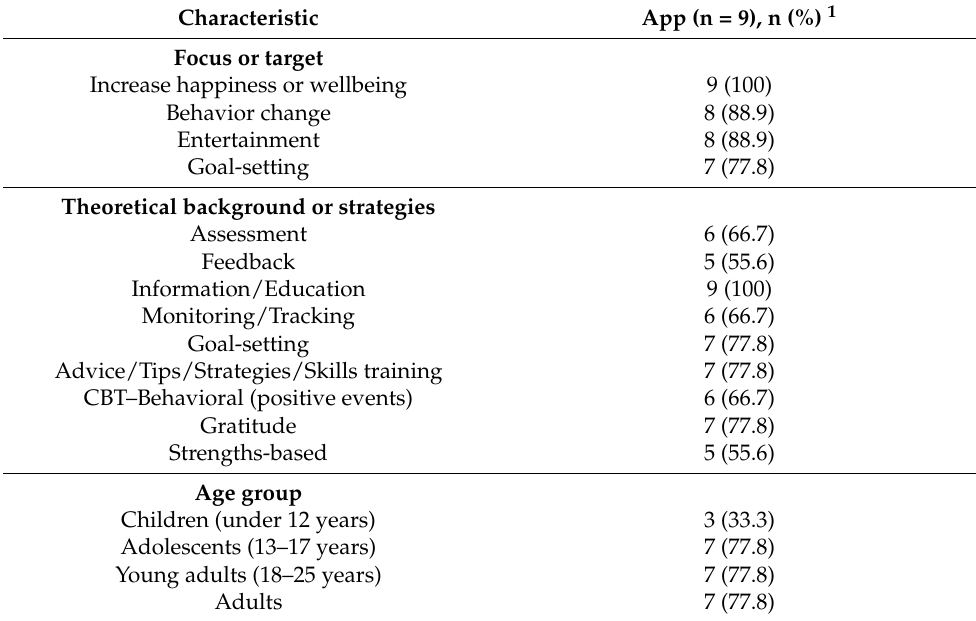
Figure 1. Flowchart of the oral-hygiene-related mobile apps selection. Table 1. Characteristics of the nine oral-hygiene-related mobile